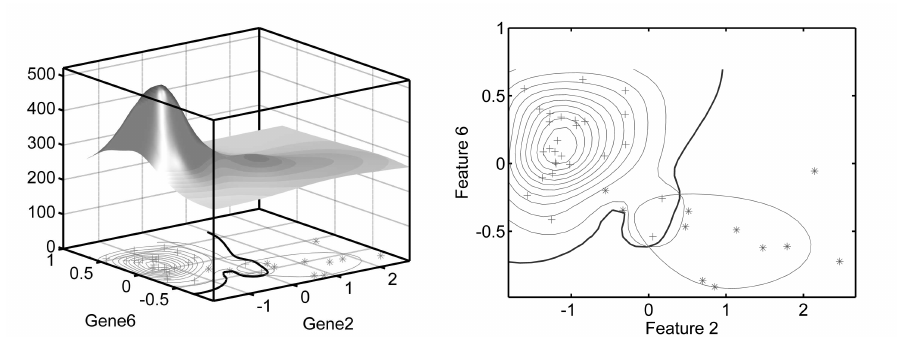
Figure 8. Gaussian kernel discriminant function with r = 1 – estimated densities and boundary error = 0.05, CV = 0.09 (SD = 0.04)